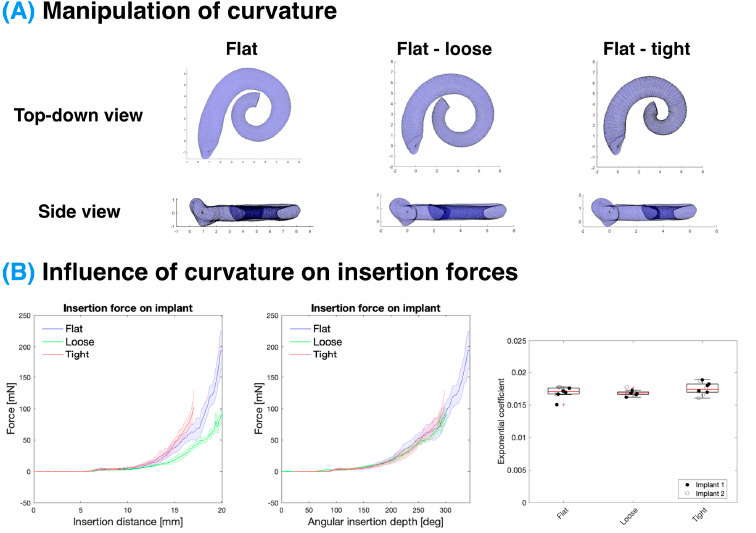
Figure 5. Influence of ST curvature on the CI insertion force. ( A ) Representations of the shape manipulation of the ST models. ( B ) Insertion force experienced by the implant for models with altered curvatures with respect to insertion distance ( left ) and angular insertion depth ( middle ; solid line-mean, shaded area-standard deviation). Statistical analysis of the exponential coefficients, which are acquired by fitting the insertion force profiles, shows no statistical significance between the models ( p > 0.05; boxplot: red line-median, box-interquartile range). Data represent n = 10 replicates per condition combined over N = 2 implants.